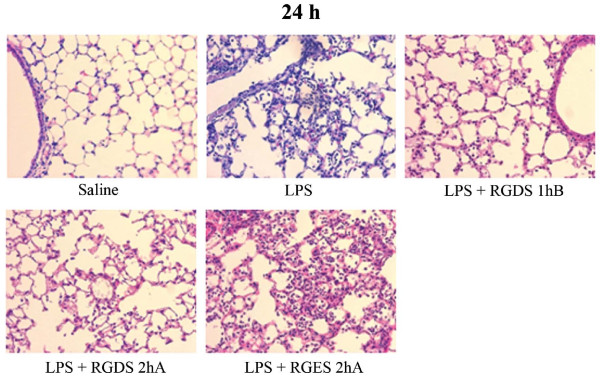
Reduction in LPS-induced lung inflammation by RGDS. Mice were administered RGDS (5 mg/kg, i.p.) once 1 h before or 2 h after LPS and were sacrificed 24 h post-LPS. Lung sections were H&E stained, as described in Methods. Representative staining from 5 mice per group are shown.